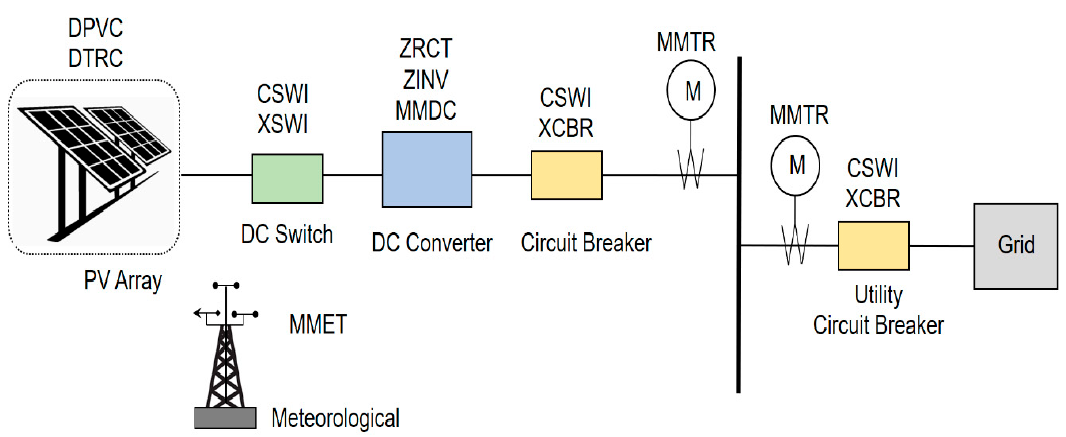
Figure 4. Logical nodes associated with photovoltaic system based on IEC 61850-7-420 standard. The electric measurements are represented with the logical node metering (MMTR). The logical node MMXU represents the metering of the AC current while MMDC represents the DC current. The logical node (MMET) represent the meteorological measurements, which includes monitoring parameters of meteorological information such as solar irradiation and ambient temperature. The list of logical nodes associated with the photovoltaic system is given in Table 4. Table 4. List of logical nodes associated with photovoltaic system based on IEC 61850-7-420.